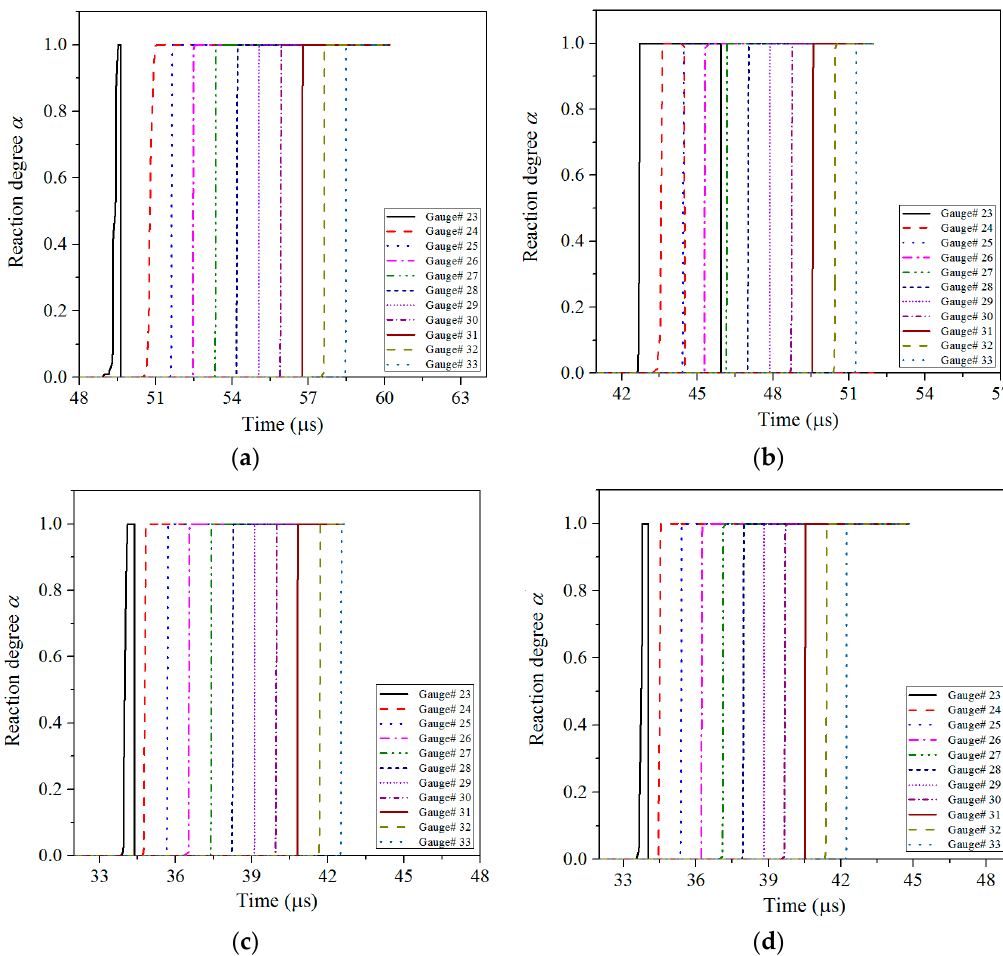
Figure 8. The reaction degree α of Gauss points in the middle of the sandwich charge for different liner materials: ( a ) copper; ( b ) floatglass; ( c ) Lucite; and ( d ) Plexiglas. Table 8. The calculation results of the u - d initiation criterion.